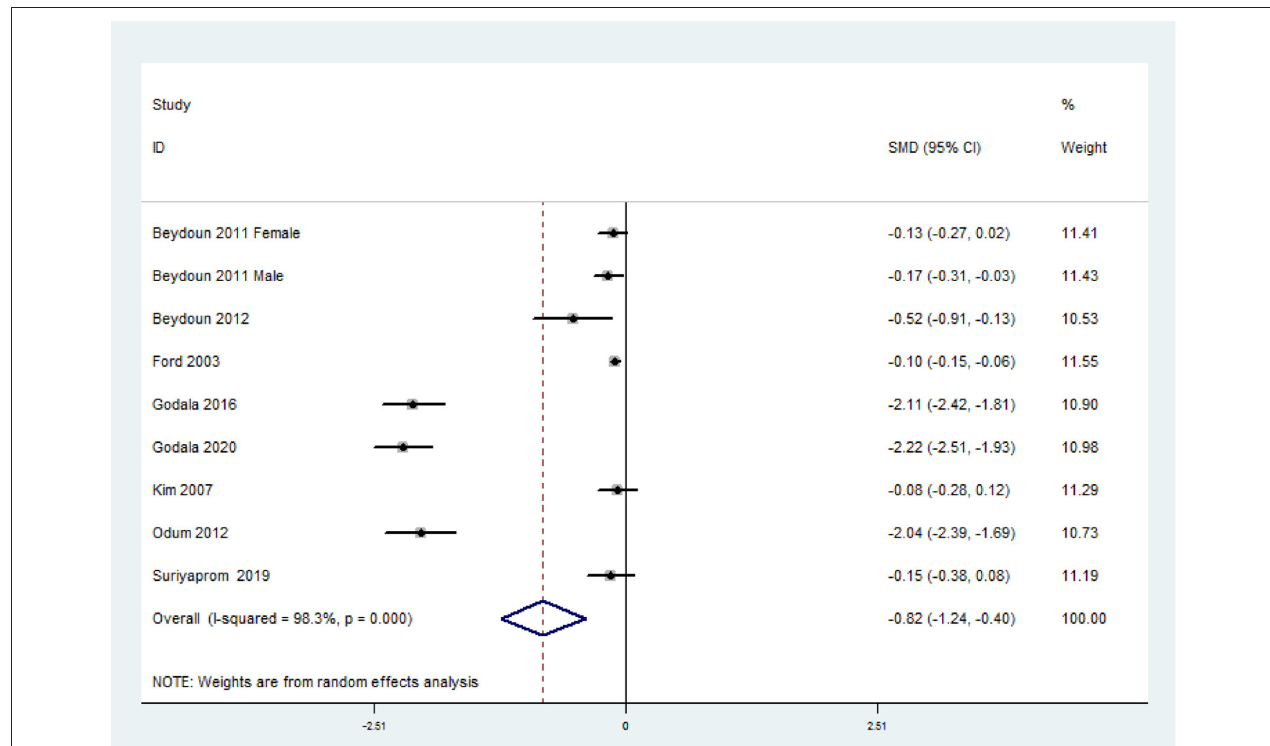
FIGURE 5 | Forest plot of meta-analysis. SMD of circulating vitamin C level for MetS vs. control subjects.